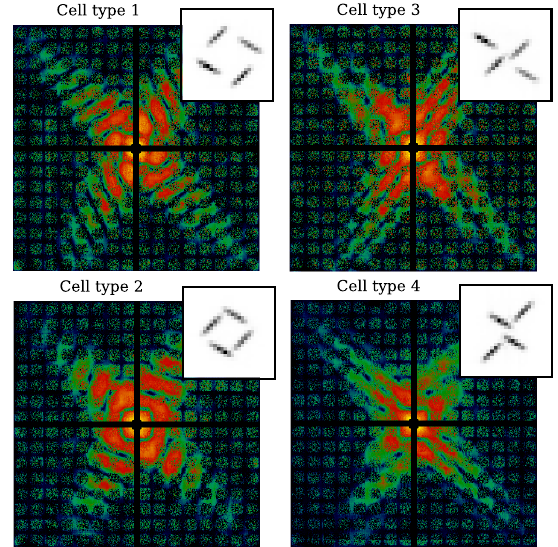
FIG. 5. Extraction of the unit-cell transform. (a) The average over eight diffraction patterns with unit-cell type 4. The inten- sities in the red box show the extracted average reciprocal-lattice transform, generated by averaging over all Wigner-Seitz cells of the average pattern. A single Wigner-Seitz cell that contributed to this average is indicated by the smaller blue box. (b) The unit-cell transform that results from dividing the average pattern by the average reciprocal-lattice transform. Note that the gridlike patches of noisy pixels are due to the relatively low diffraction signal in those regions.